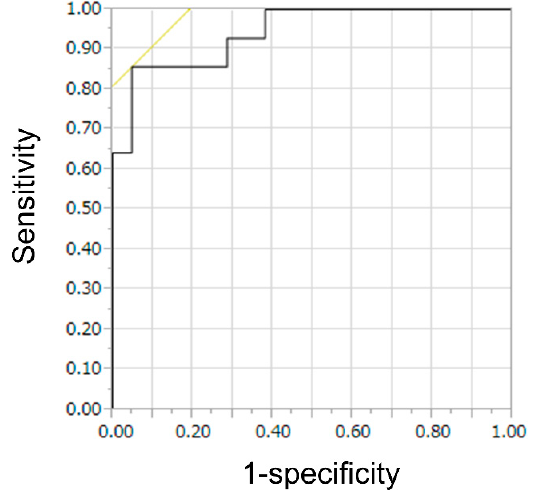
Figure 5. Receiver operating characteristic (ROC) analysis for velocity of reduction of time–intensity curve analysis in lesion of homogeneous enhancement. ROC analysis for velocity of reduction shows that the area under the curve is 0.92. Table 5. Diagnoses of contrast enhanced endoscopic ultrasound with qualitative and quantitative evaluation.